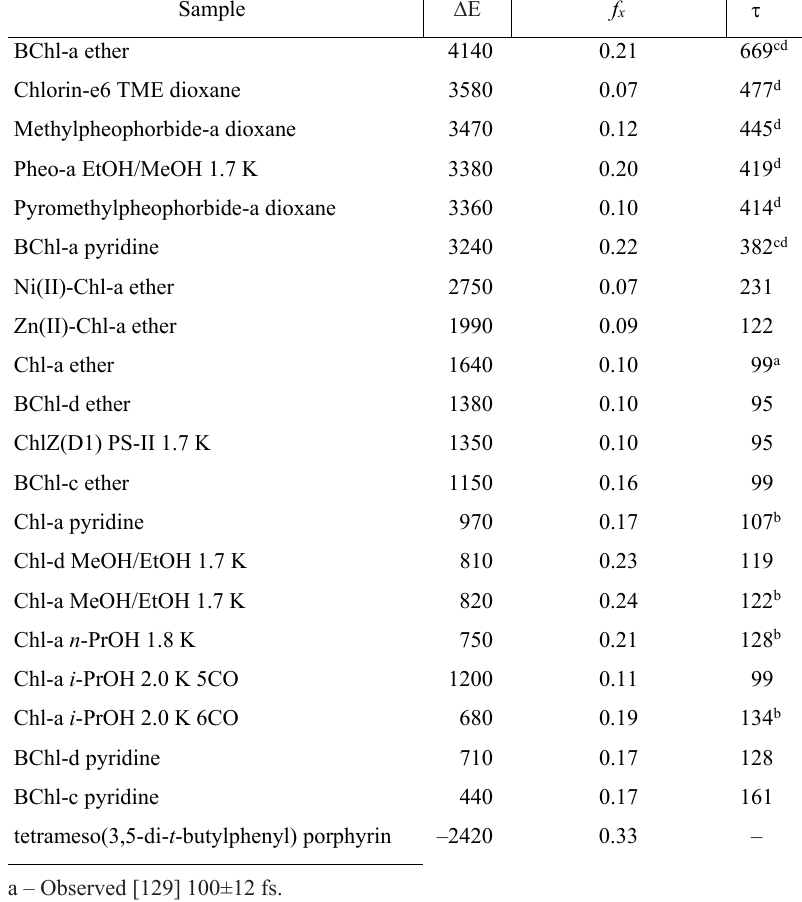
Table 3. Fitted values of the unperturbed Q fraction f of absorption attributed to Q x